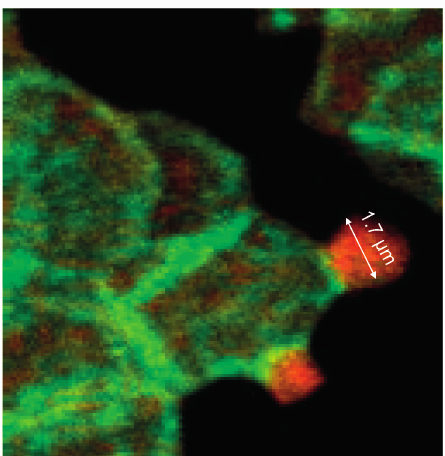
Figure 9. Merger of the red (actin) and green (spectrin) channels of the confocal microscope after examination of double-stained erythrocytes after incubation in a plasma/Iopromide370 mixture (reprinted from reference [20], Copyright 2013, with permission from IOS Press; primary magnification 1:63; zoom factor